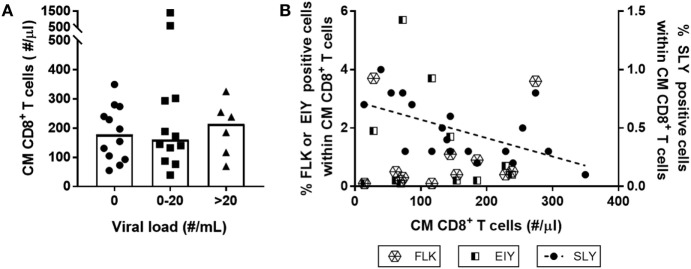
Neither low-level human immunodeficiency virus (HIV) viremia nor the presence of HIV-specific T-cells explain increased central memory (CM) CD8+ T-cell numbers during long-term (LT) combination anti-retroviral treatment (cART). CM CD8+ T-cell numbers in HIV-infected individuals on LT cART were neither associated with (A) levels of plasma HIV RNA load (grouped by the number of viral RNA copies/ml plasma determined using the Roche Cobas Taqman v2.0 assay), nor by (B) the percentage of HIV-specific CM CD8+ T-cells, measured using tetramers of the three immuno-dominant HIV-1 peptides: HLA-A2-SLYNTVATL (SLY), HLA-B8-FLKEKGGL (FLK), and HLA-B8-EIYKRWII (EIY). Depicted are individual values (symbols), medians (bars in panel A), and a linear regression line for the results of HLA-A2-SLYNTVATL (P = 0.01).